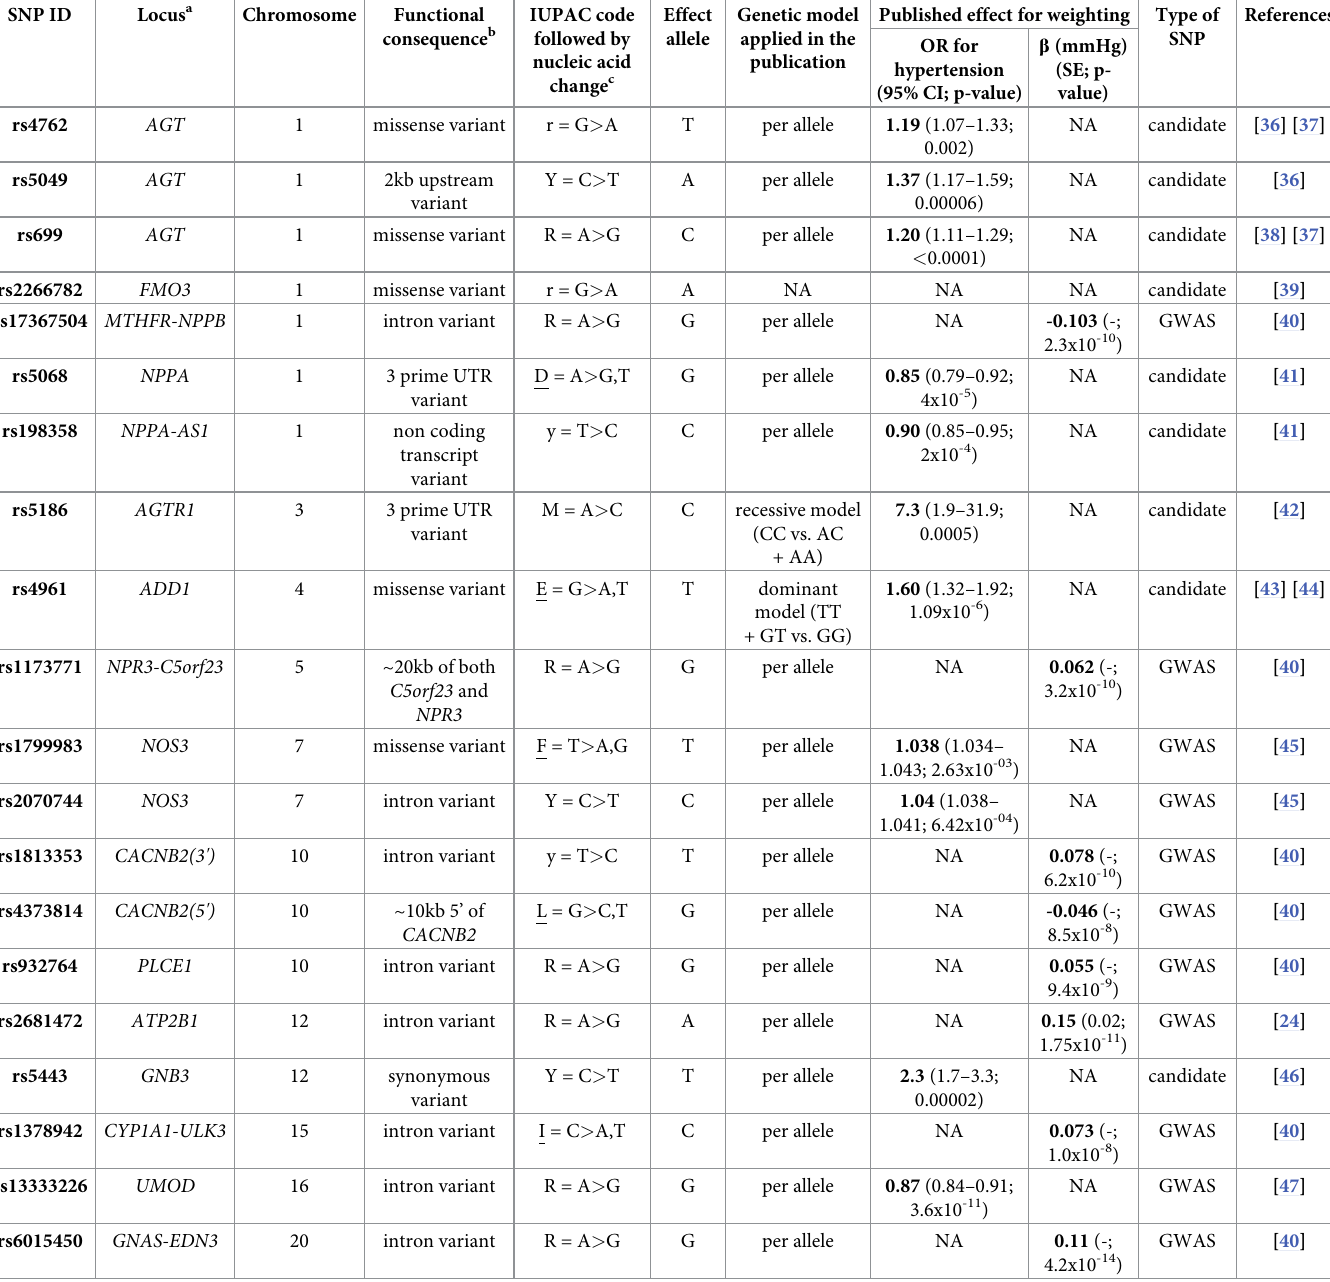
Table 1. List of SNPs and their loci with the effect alleles and effect size estimates included in the study. SNP